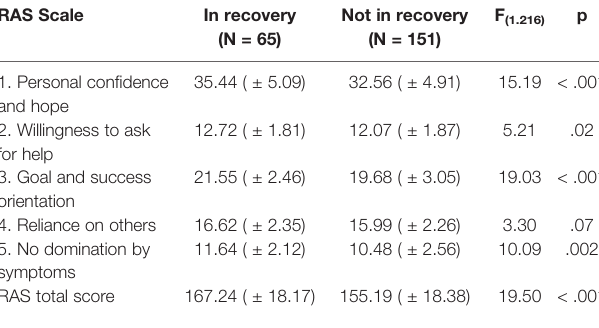
TABLE 4 | Means (SD) obtained by the two groups on the RAS